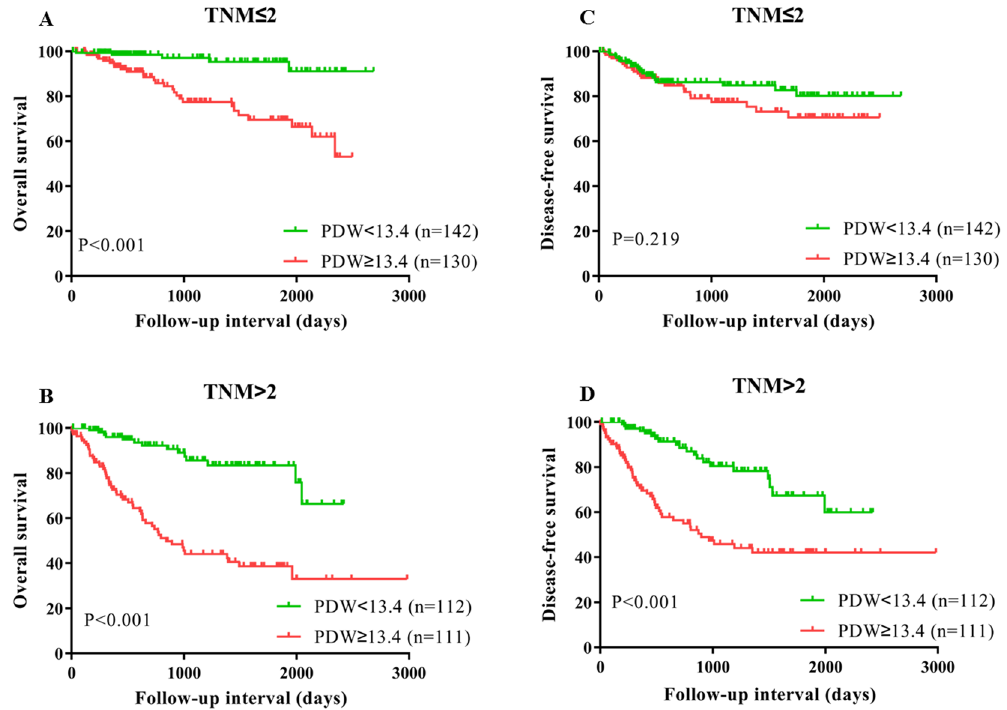
Figure 5. Subgroup analysis based on pathological stage, Kaplan–Meier curves for OS ( A,B ) and DFS ( C,D ), which was stratified according to PDW value (PDW < 13.4 vs. PDW ≥ 13.4) for ESCC patients after surgery. The difference was evaluated by log-rank